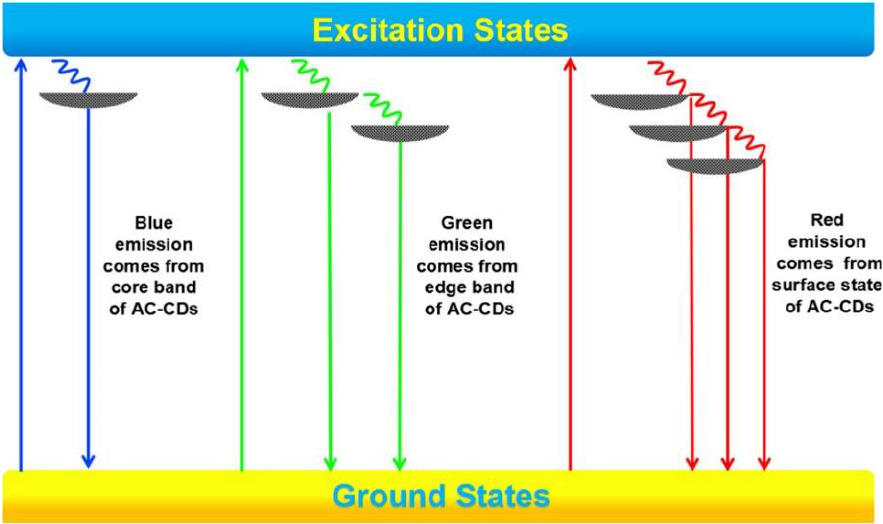
Figure 8. Energy level structures to explain the PL behaviors of the three different emissions from multicolor emissive CDs (indicated here as AC-CDs). (Reprinted from [111]; with the permission of the American Chemical Society).